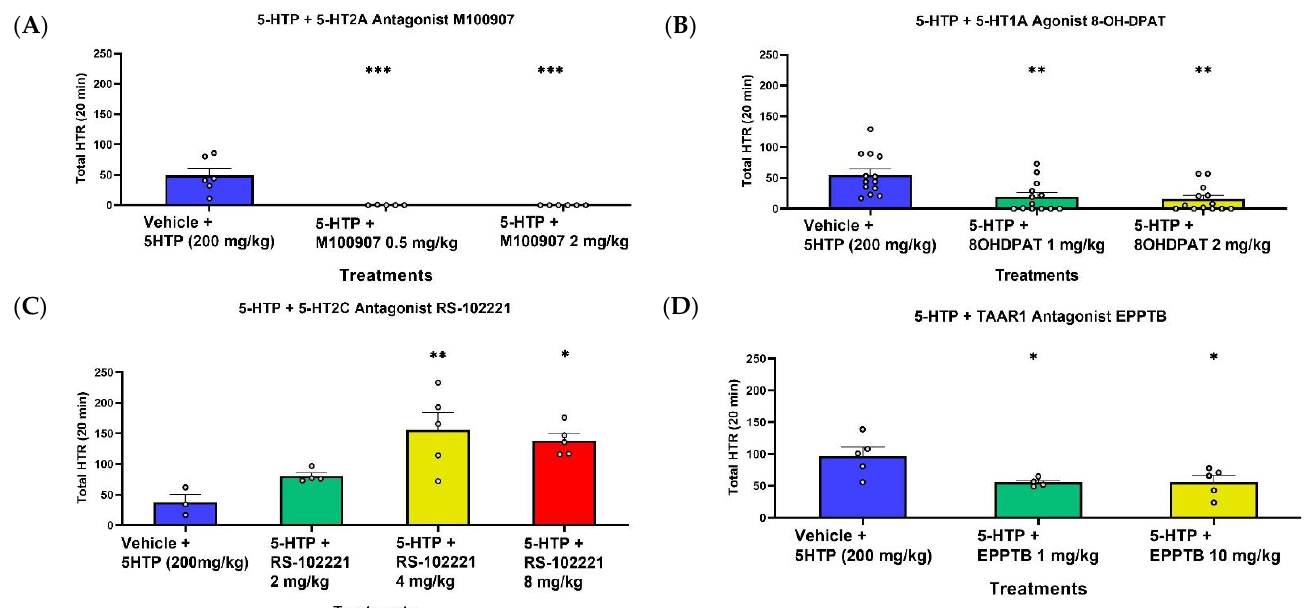
Figure 2. Total 5-HTP-induced HTR ( A − D ) during 15 – 30 min post injection with different co-treatments. ( A ) Effect of pre-treatment with M100907 0.5/2 mg/kg + 5-HTP 200 mg/kg or vehicle + 5-HTP 200 mg/kg ( n = 5 − 6). ( B ) Effect of pre-treatment with 8-OH-DPAT 1/2mg/kg + 5-HTP 200 mg/kg or vehicle + 5-HTP 200mg/kg ( n = 13). ( C ) Effect of pre-treatment with RS-102221 2/4/8 mg/kg + 5-HTP 200 mg/kg or vehicle + 5-HTP 200 mg/kg ( n = 3 − 5). ( D ) Effect of pre-treatment with EPPTB 1/10mg/kg + 5-HTP 200 mg/kg or vehicle + 5-HTP 200 mg/kg ( n = 4 − 5). Compared to vehicle, * p < 0.05, ** p < 0.01, *** p < 0.001. Error bars represent SEM.